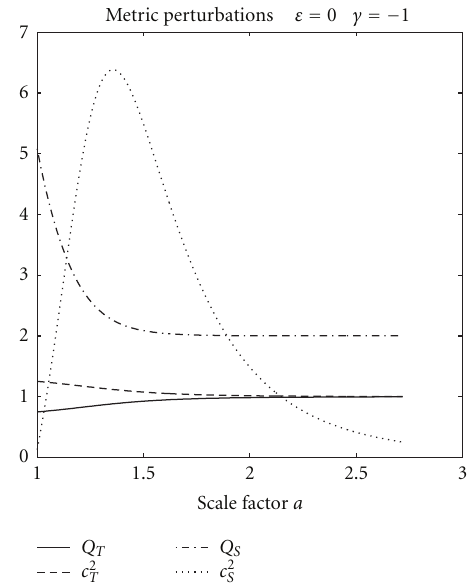
, Q T , c 2 , as defined S T